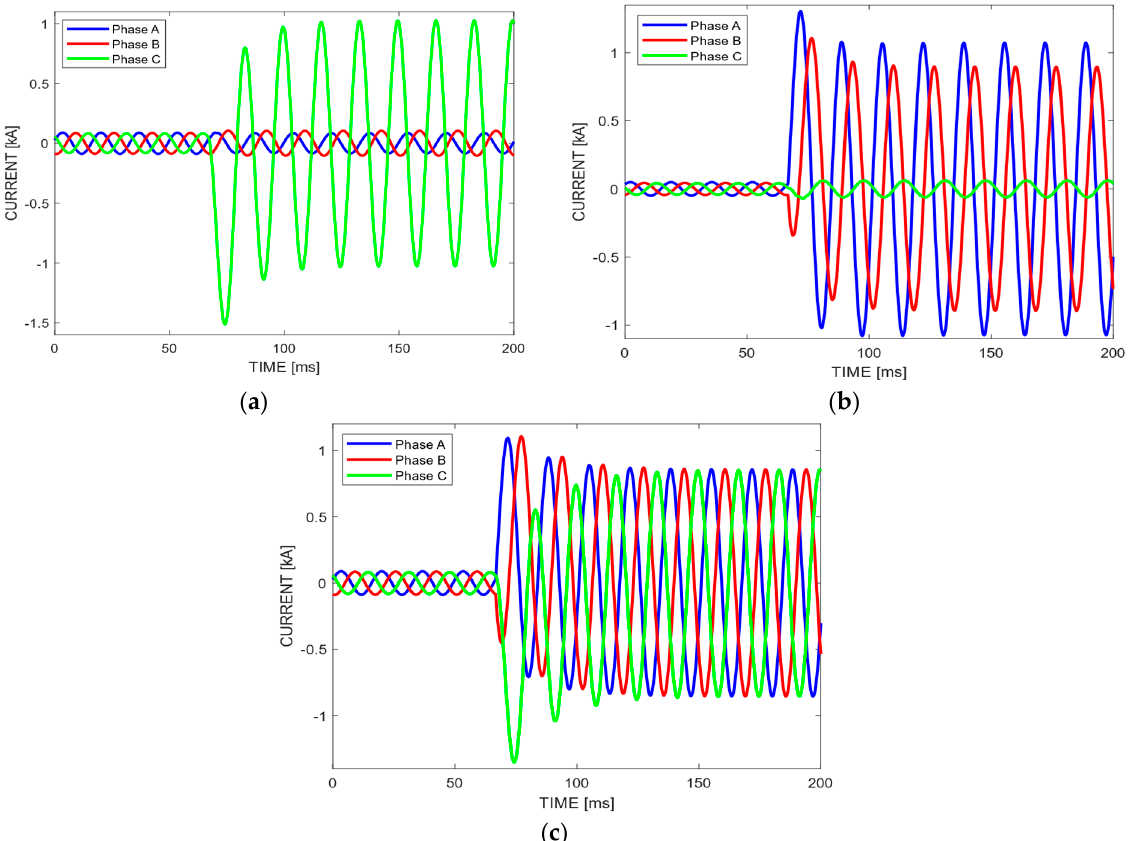
Figure 1. Fault types: ( a ) line-to-ground fault (SLGF); ( b ) double line-to-ground fault (DLGF); and ( c ) three-phase-ground fault (LLLGF).